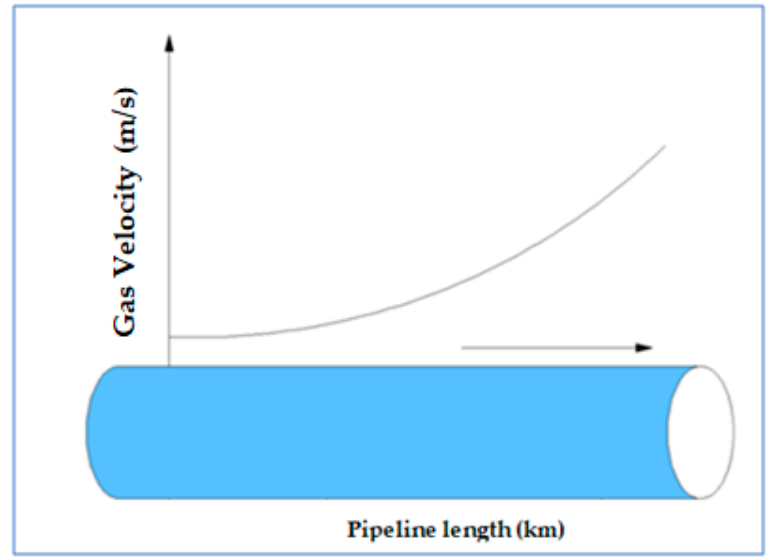
Figure 3. Typical velocity profile behaviour in gas pipelines.